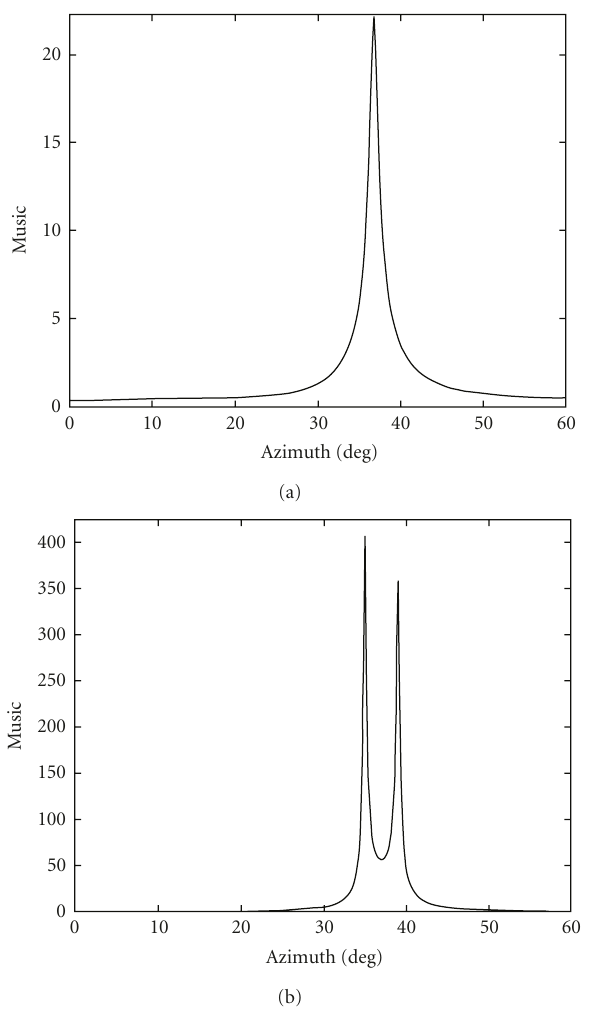
Figure 16: Localization